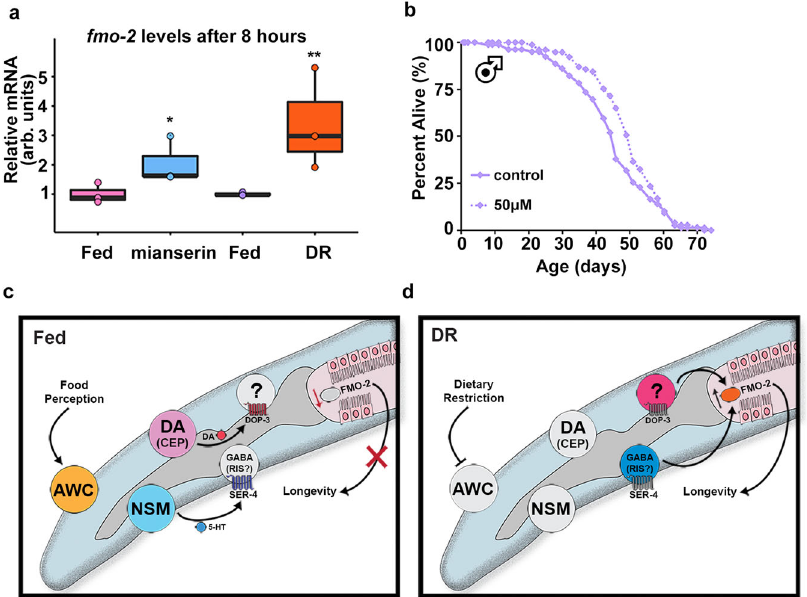
Fig. 5 Serotonin antagonist mianserin induces FMO and improves health in Drosophila. Fmo-2 mRNA levels ( a ) after eight hours of 2 mM mianserin (blue) or starvation (orange) compared to water controls (pink and purple, respectively). n = 3 (fed, mianserin, fed, DR) biologically independent experiments. p -value = 0.0365 (fed vs. mianserin), 0.00914 (fed vs. DR). Survival curves of male fl ies treated with water (solid line) or 50 µ M (dotted line) mianserin ( b ). Panels c and d depict the current model for the cell non-autonomous DR/food odor signaling pathway. “ DA ” stands for dopaminergic neuron. * P < .05, ** P < .01 when compared to control or fed (Welch Two Sample t -test, two-sided). The box plots display the median by the middle line of the box. The upper boundary of the box indicates the 75% interquartile range, and the lower boundary indicates the 25% interquartile